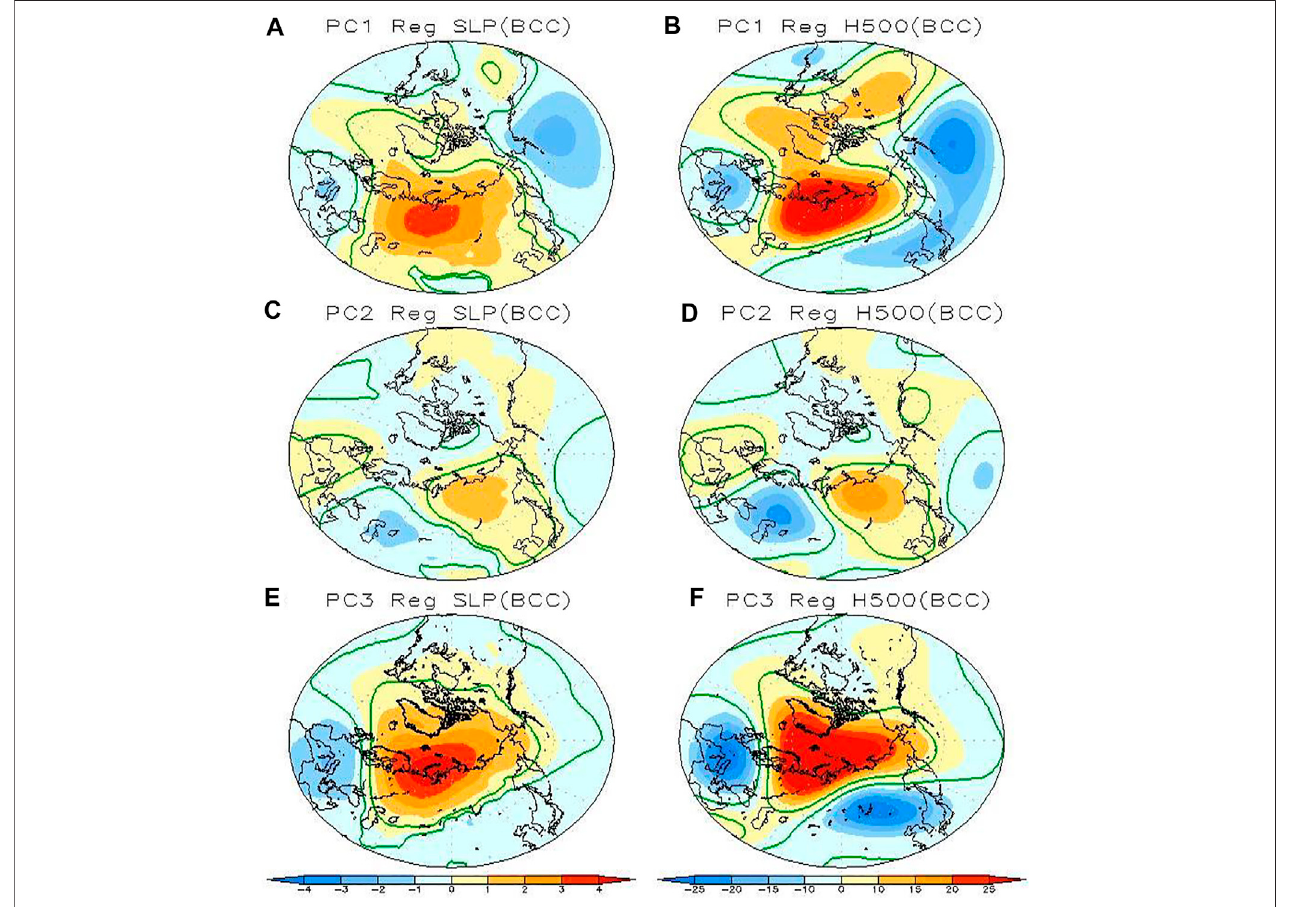
FIGURE 11 | Regressed anomalies of DJF (A) SLP (shading, units: hPa), (B) 500 hPa geopotential height (shading; units: m) onto the PC1, (C,D) PC2, and (E,F) PC3 index from the BCC-CSM2-MR model. The green line indicates the value signi fi cantly exceeding the 95% con fi dence level.